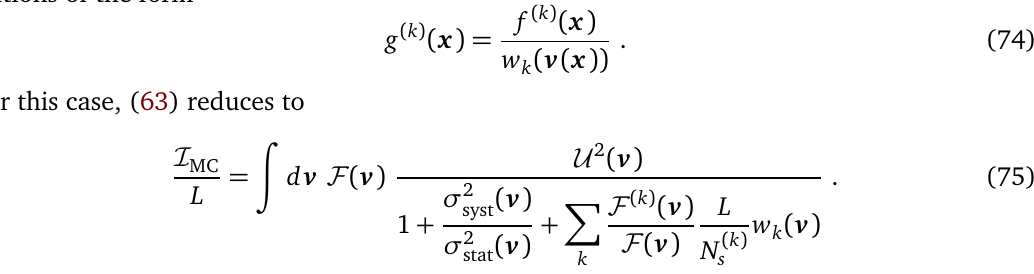
( k ) ( v ) F ( v ) by target